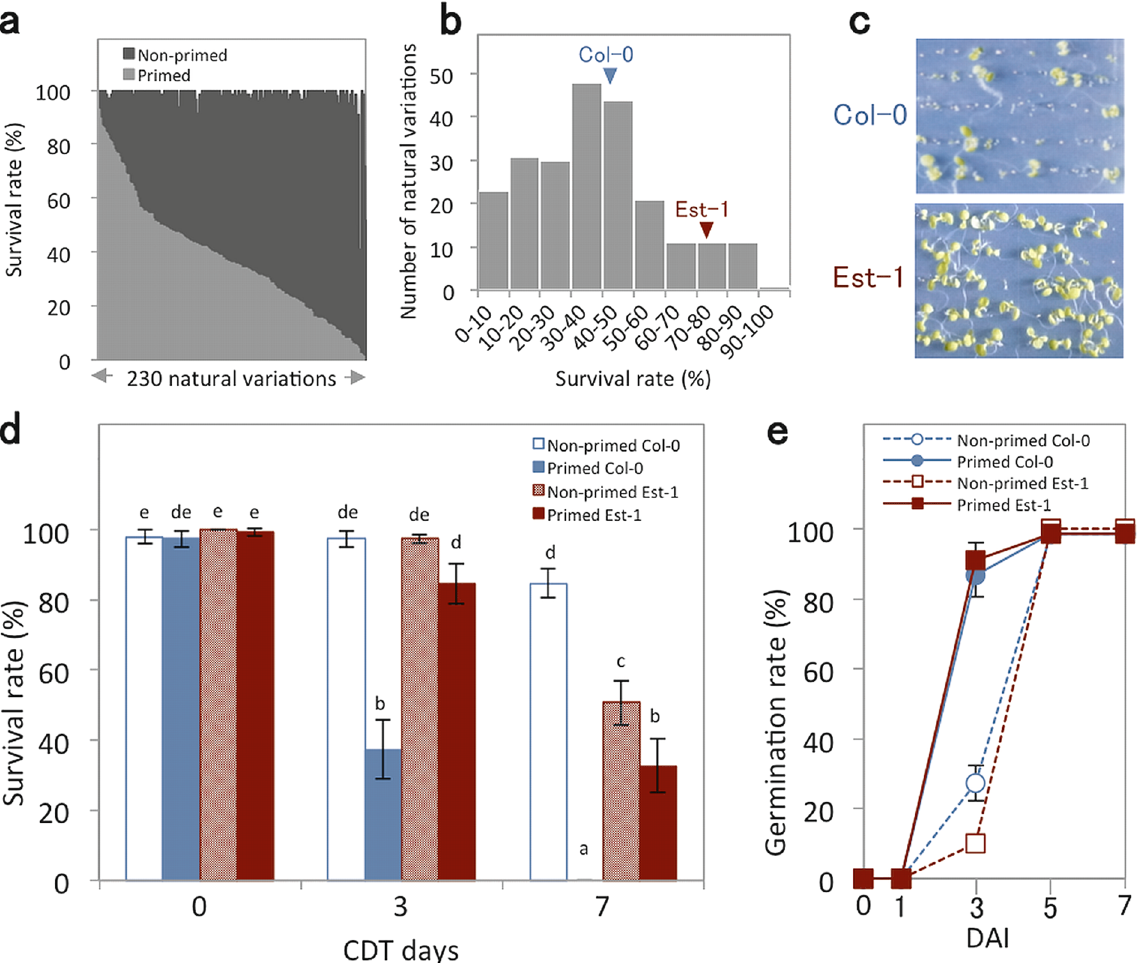
Figure 3. Seed longevity of Arabidopsis natural variants. ( a ) Survival rates of 230 Arabidopsis natural variations subjected to CDT for 3 days before (non-primed; dark grey bars) and after (primed; light grey bars) priming. ( b ) Frequency distribution of survival rates among the natural variants. ( c ) Photographs of Col-0 and Est-1 seedlings developed after priming and subsequent CDT for 3 days. ( d ) Survival rates of Col-0 and Est-1 before (non-primed) and after (primed) priming and subsequent CDT for 0, 3 and 7 days. ( e ) Germination speed of Col-0 and Est-1 before (non-primed) and after (primed) priming without CDT determined as the number of seedlings with green cotyledons. For ( d ) and ( e ), values presented are means ± SD of three replicates. Different letters in ( d ) indicate significant differences (P < 0.05, Tukey-Kramer